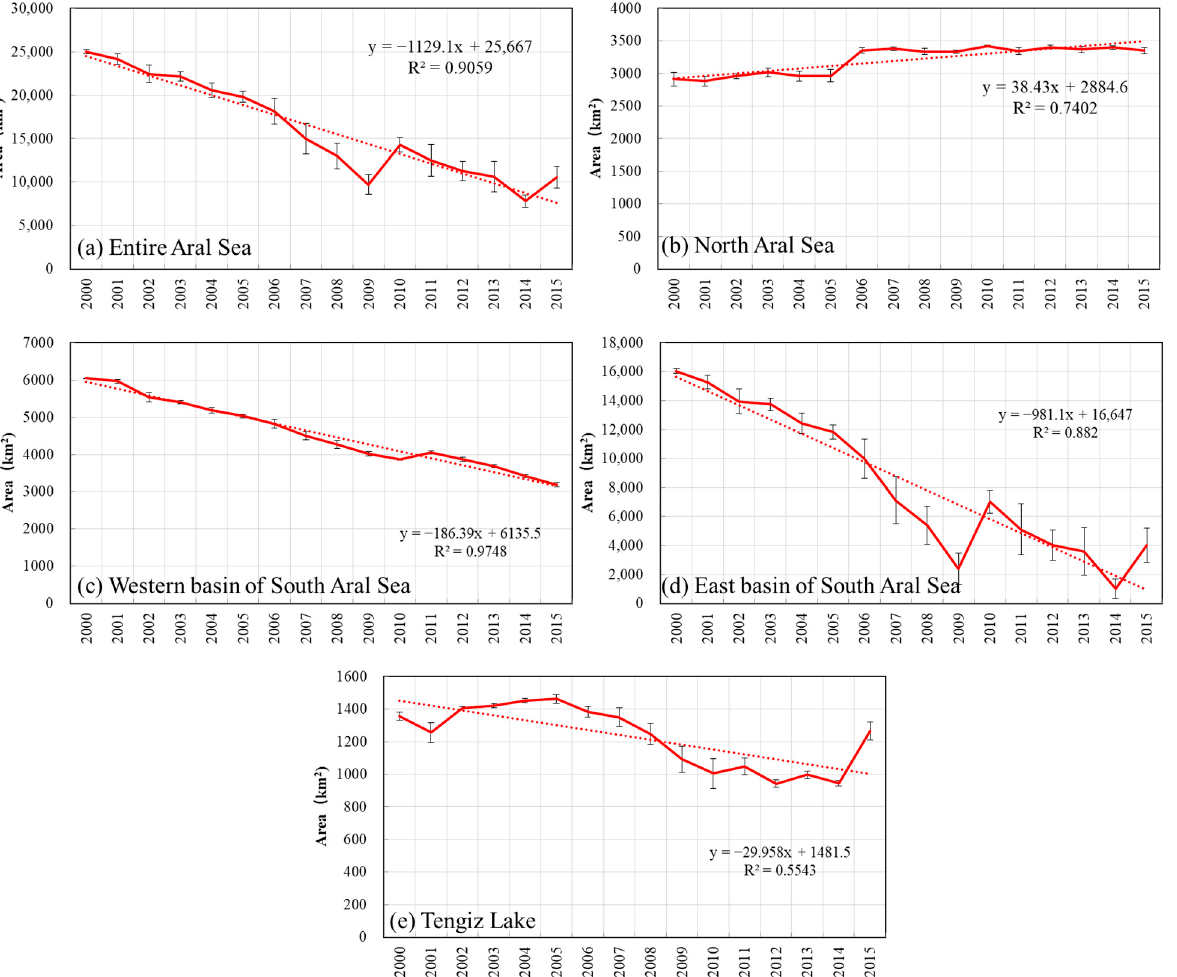
Figure 9. Yearly and intra-annual area changes for Aral Sea and Tengiz Lake from 2000 to 2015.